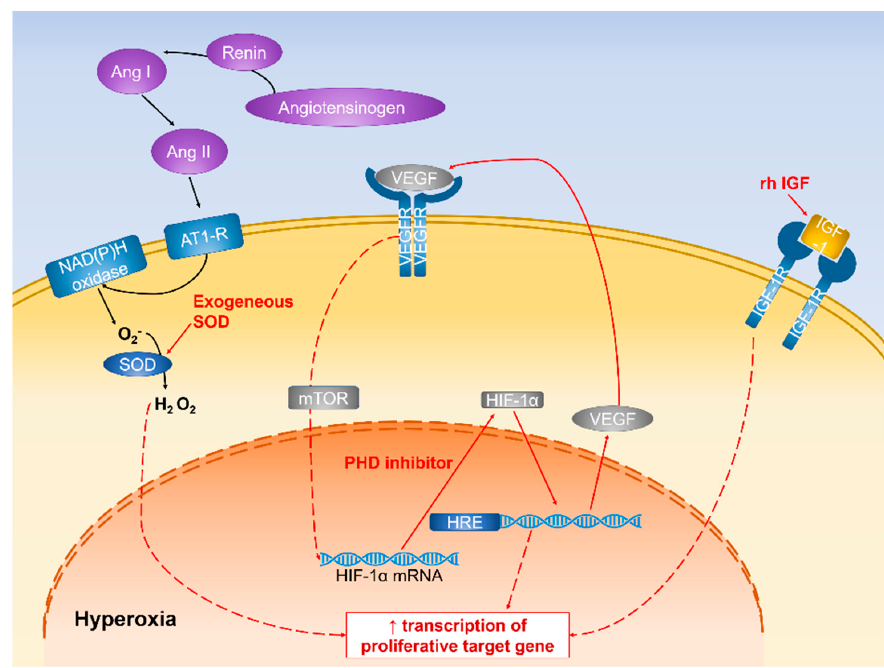
Figure 2. Schematic diagram representing the mechanism of vascular changes in hyperoxic condition. Pathways that confer vascular protection are highlighted in red.